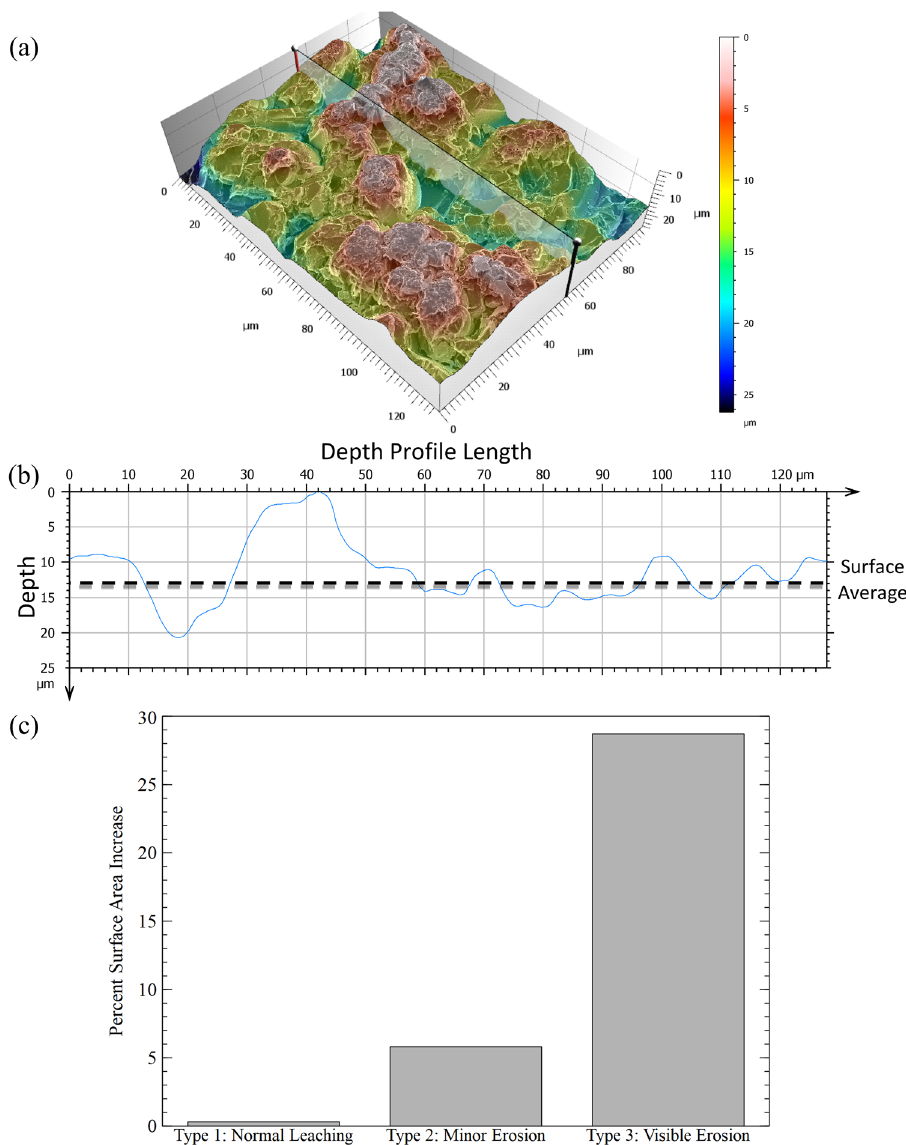
Figure 6. 3D Reconstruction of a Type 3 surface from a 10 W cm −2 , 1 h experiment created using MountainsSEM ( a ) showing the heavy roughening of the glass surface due to ultrasonication. This type of surface is visible macroscopically. The line across the image indicates where the depth profile ( b ) was taken. The average surface height is marked with a dashed line in the depth profile. The largest surface features are ~ 10–15 microns different from the average. The bar chart made with Veusz ( c ) compares the surface area changes measured from the reconstructions for each type of surface. The results for Type 2 and 3 Surfaces come from 20 W cm −2